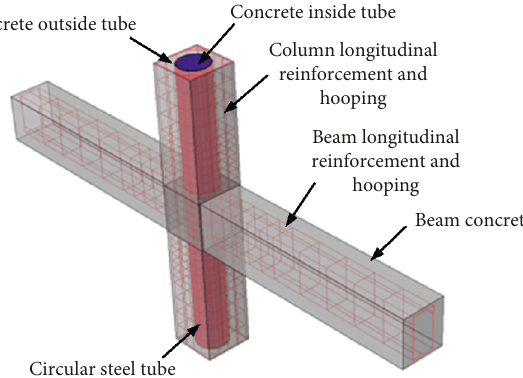
Figure 1: Whole geometric model of framework